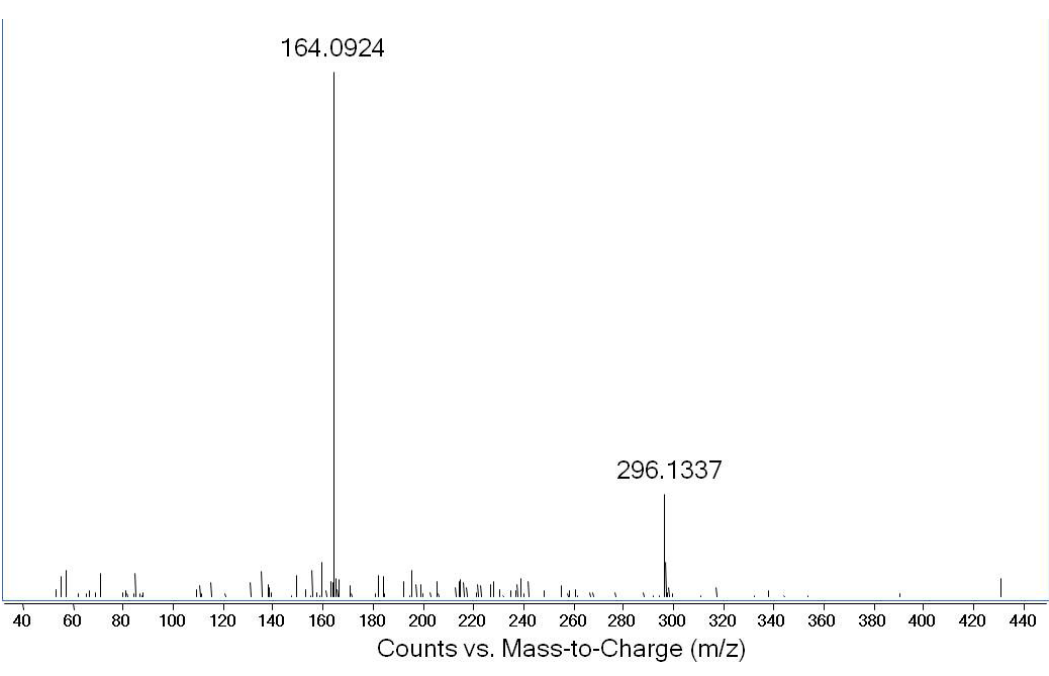
Figure 3. MS 2 fragmentation of the ribonucleoside with m/z